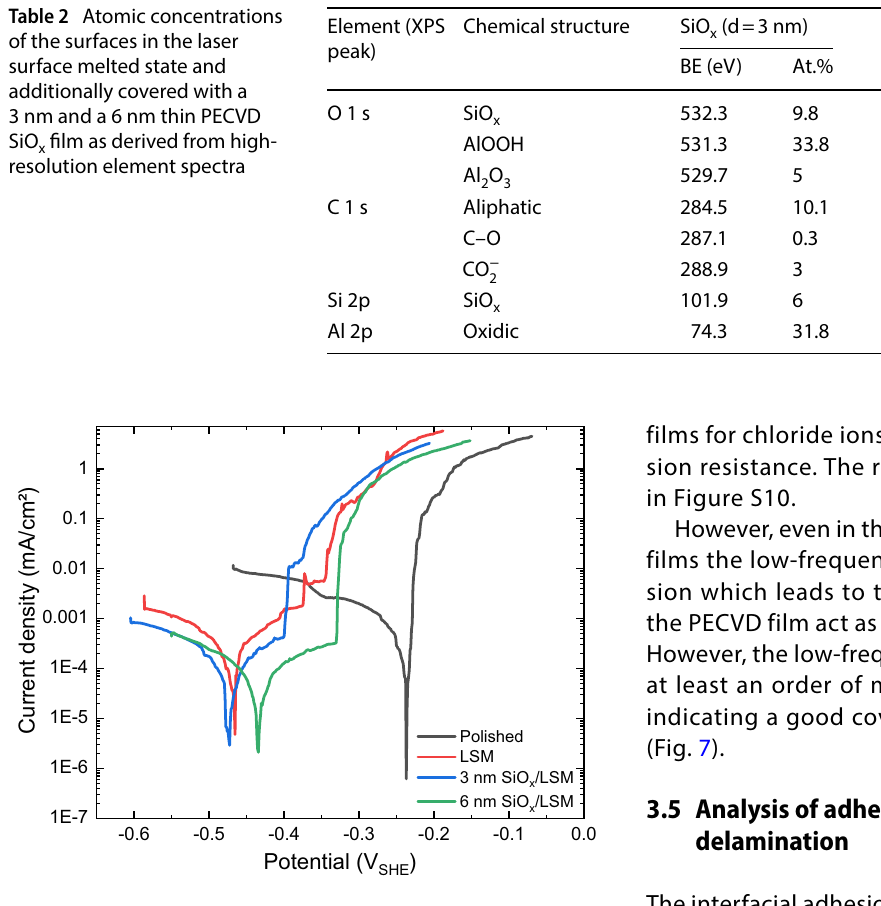
Fig. 5 Results of linear sweep voltammetry of the studied samples in borate buffer with 0.05 M chloride (pH